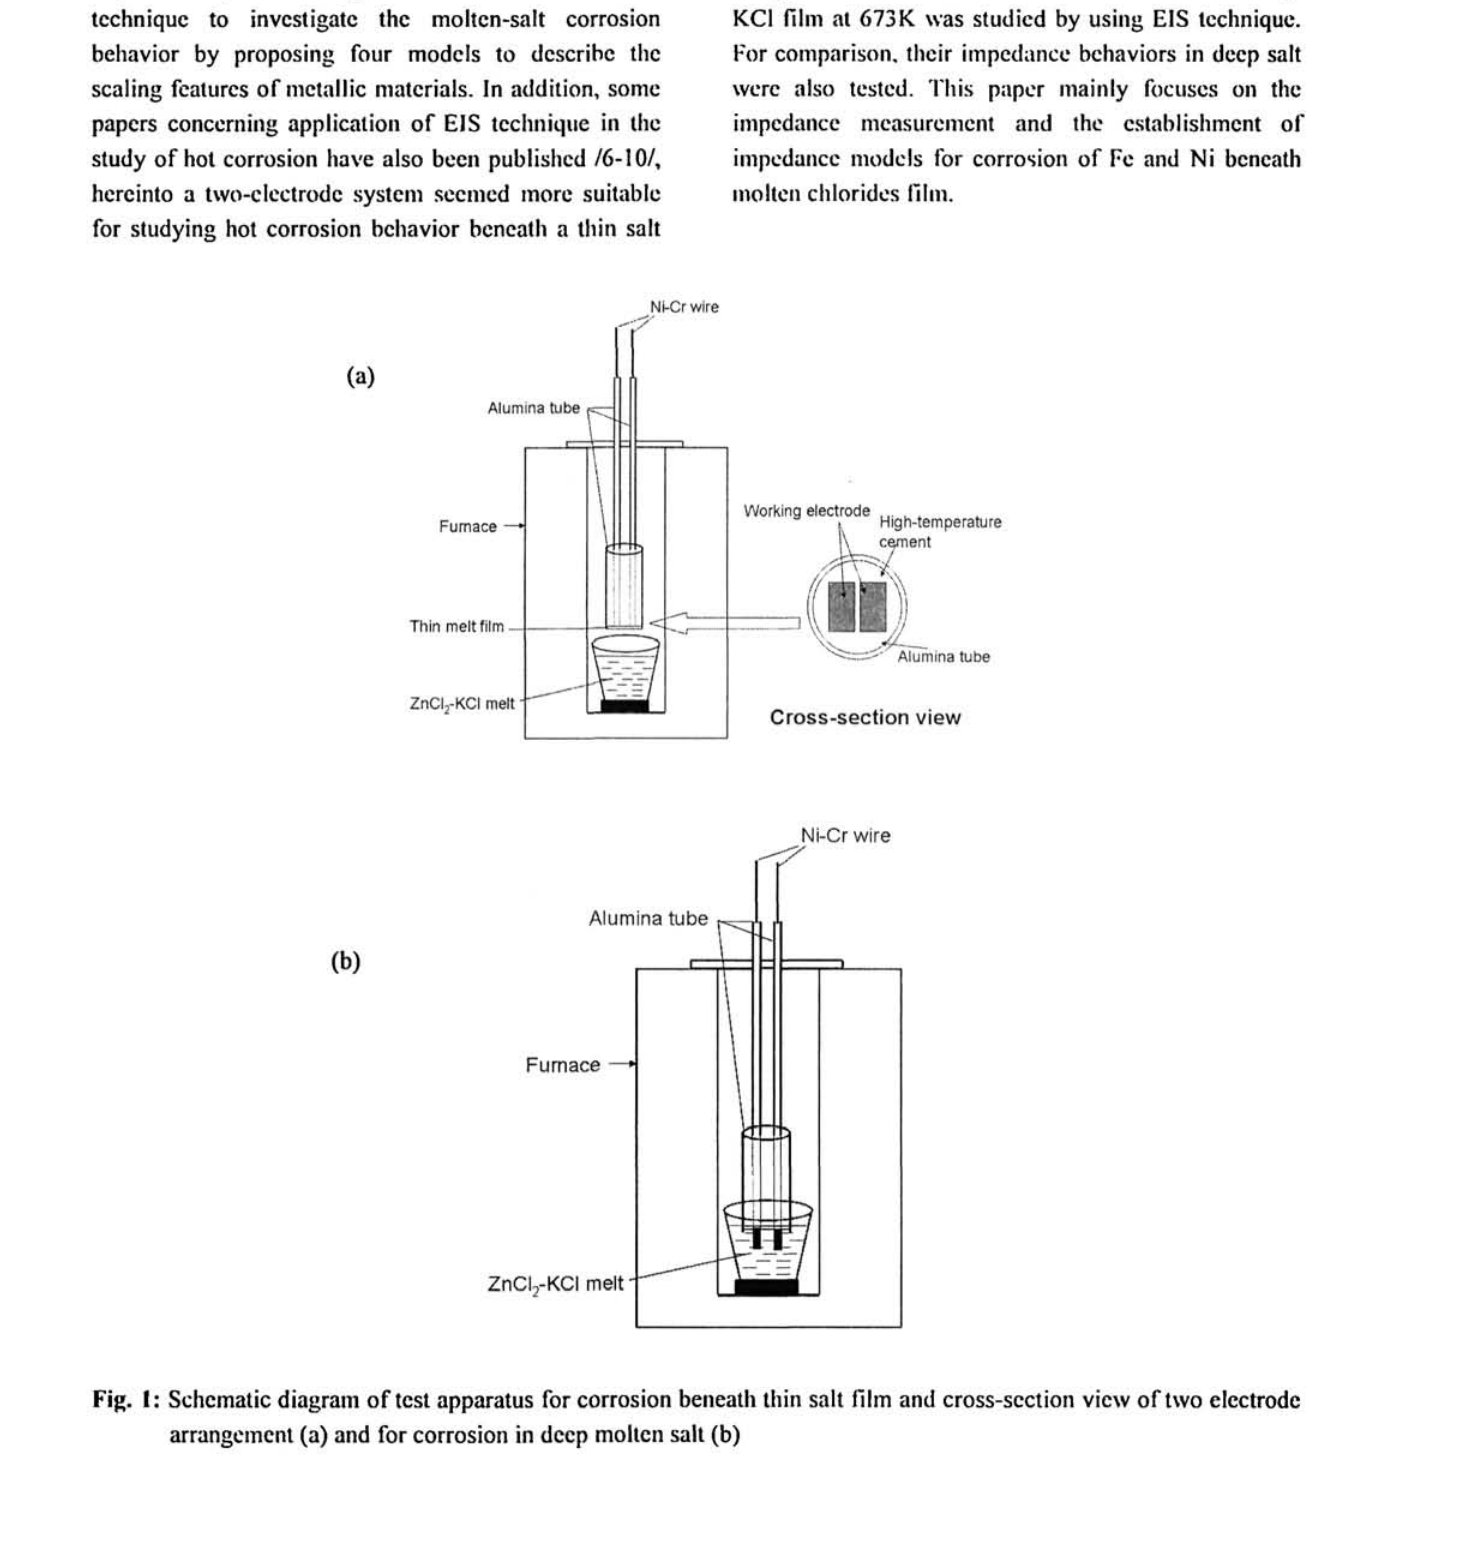
Fig. 1: Schematic diagram of test apparatus for corrosion beneath thin salt film and cross-section view of two electrode arrangement (a) and for corrosion in deep molten salt (b)